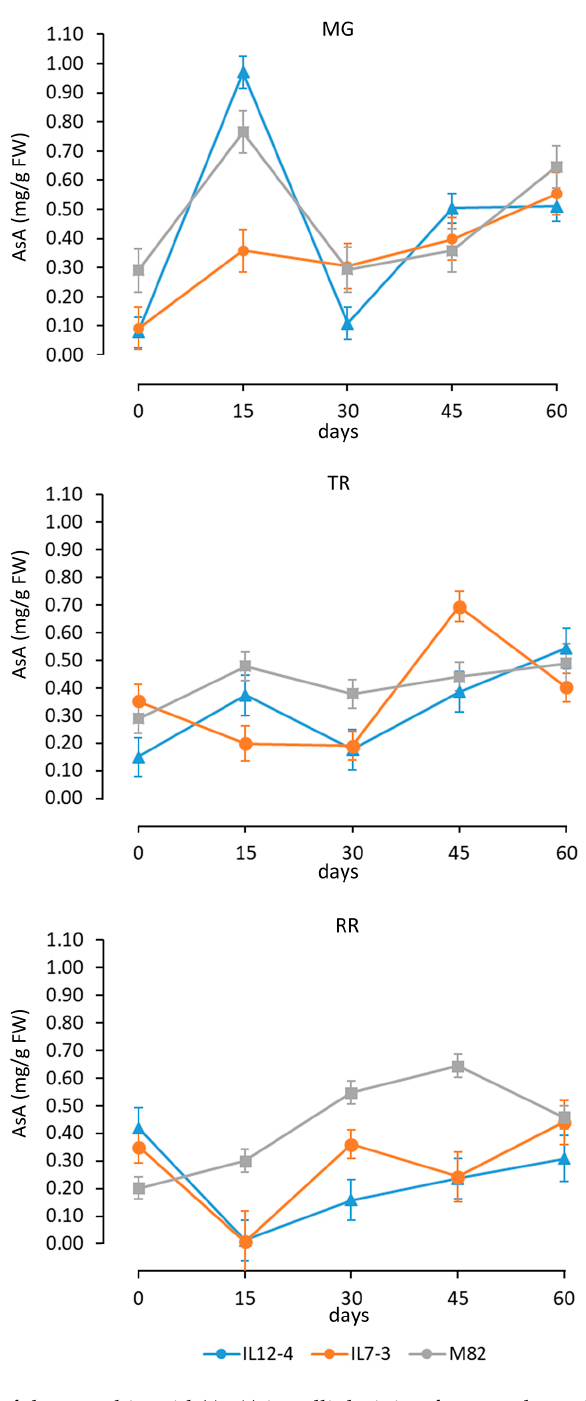
Figure 3 . Dynamics of the ascorbic acid (AsA) in calli deriving from explant of fruits at the mature green (MG), turning (TR), and red ripe (RR) stage. For each source of explants, the graph reports the mean and standard deviation in the different genotypes from 0 to 60 days of tissue culture. For explants from turning red tomatoes, the interaction between time and genotype was more evident. While the IL12-4 and M82 had a similar accumulation trends, the IL7-3 showed first a reduction, and then a peak at 45 days. Also for this time of explants, all the three genotypes reached similar AsA values at 60 days. For explants of red ripe fruits, the two ILs had a similar behavior. As